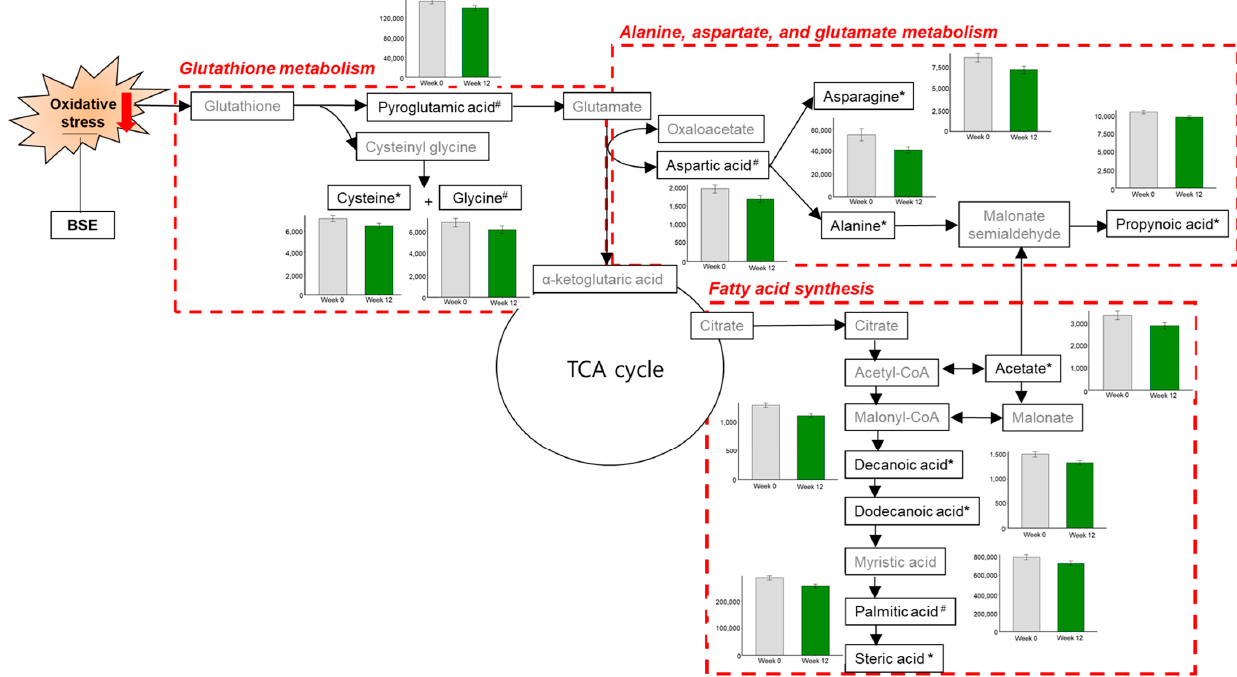
Figure 4. Overview of the KEGG metabolic pathways in response to BSE supplementation. Arrows indicate metabolic direction. Bar graphs compare the individual metabolites’ changes in the BSE group at the baseline (grey) and endpoint (green) of the 12-week study. * q < 0.05, # q < 0.1. BSE, barley sprouts extract powder.